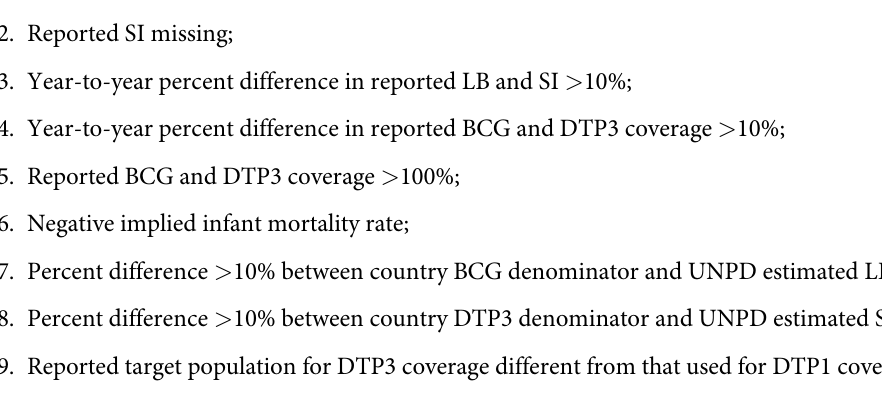
Fig 3. The regional number of LB and SI reported as BCG and DTP3 target populations through the JRF compared to UNPD LB and SI estimates.